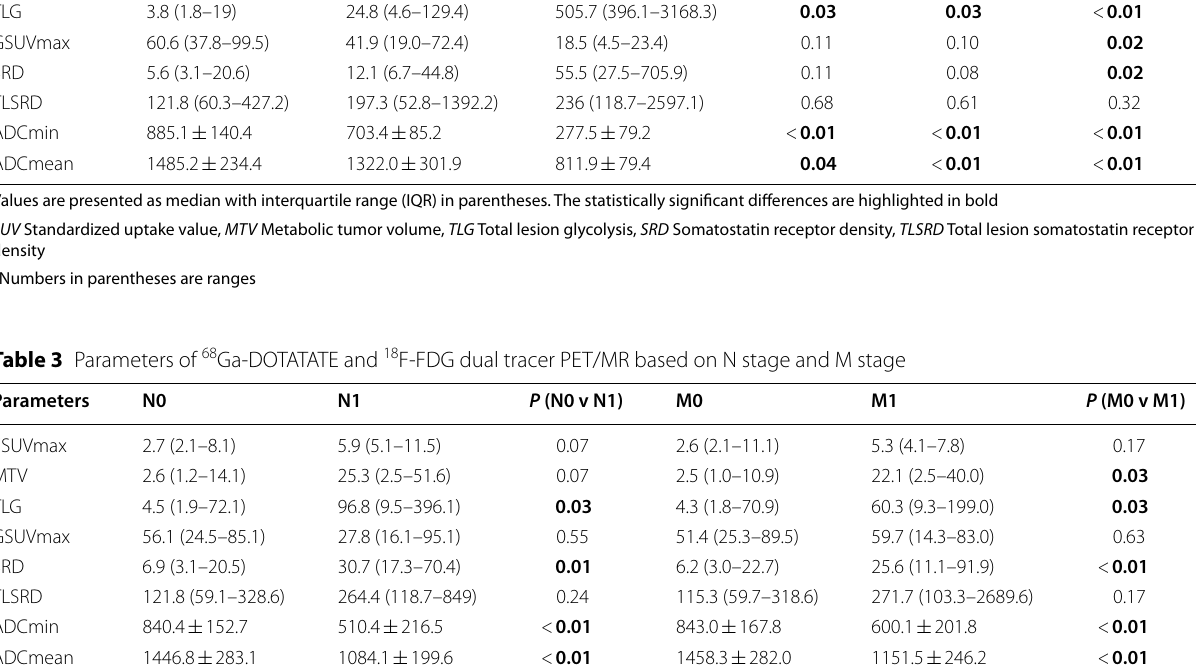
Table 2 Parameters of 68 Ga-DOTATATE and 18 F-FDG dual tracer PET/MR based on tumor grade